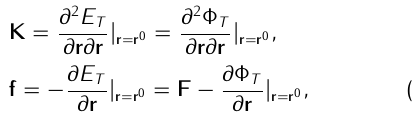
The position of the doped atom and vacant site as shown in Figure 1(c) are symmetrical with respect to the x 1 =